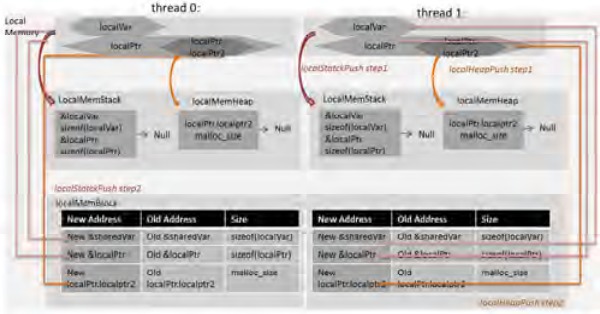
Fig. 11. Process Layout of Local Memory